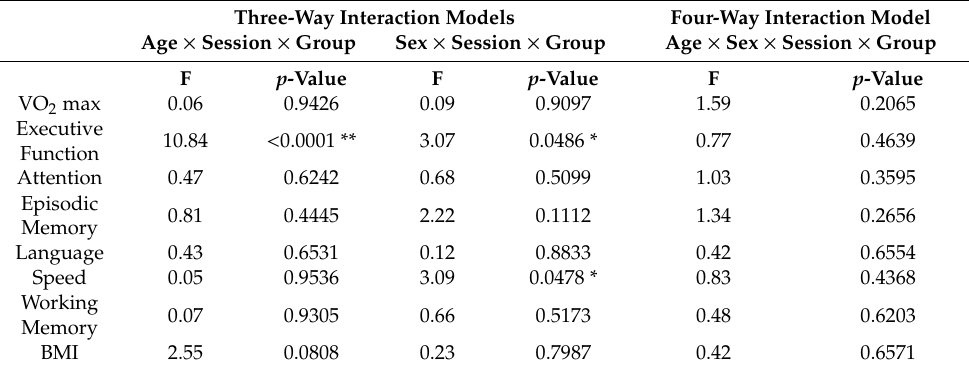
Table 3. F-statistics for all three-way and four-way interaction